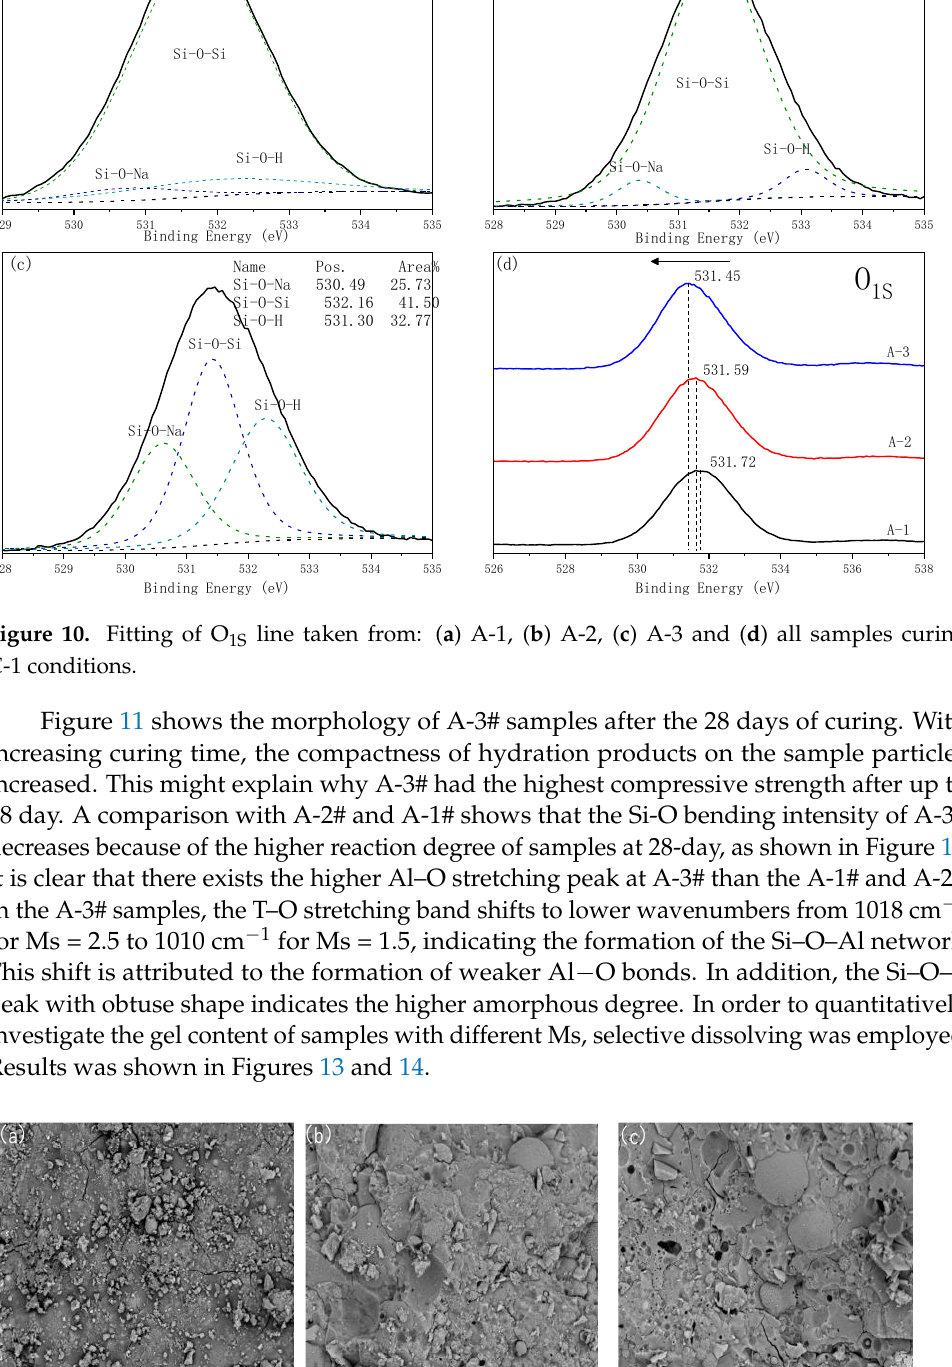
452 Figure 12. FTIR spectra of samples with different Ms at C-1 curing condition. Figure 13. SEM spectra of samples after dissolution with different acids: ( a ) bulk samples, ( b ) samples after SAM, ( c ) samples after HCl.